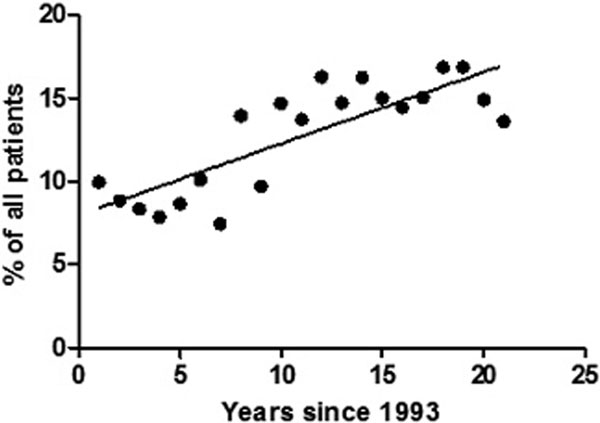
Proportion of patients admitted to ICU aged >80 years, over time.